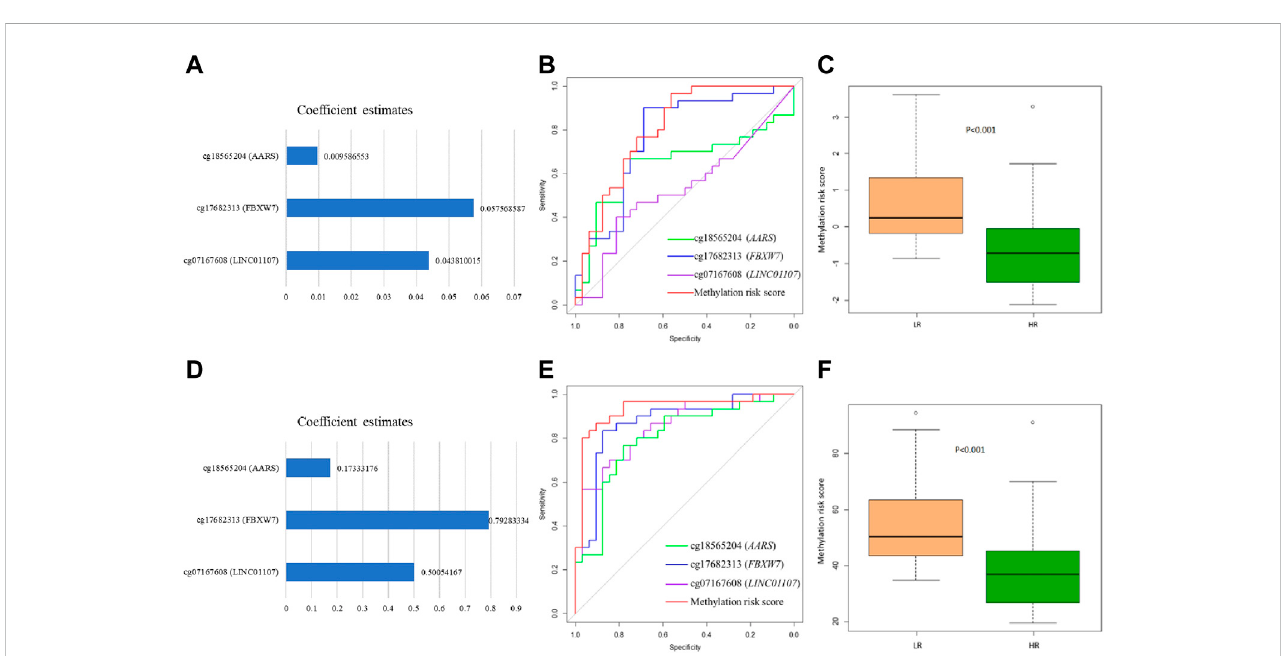
FIGURE 2 Receiver operating characteristic (ROC) curves and forest plot of methylation probes and methylation risk score using logistic regression and support vector machine in LR (low resilience) versus HR (high resilience) groups in the validation set. (A) Forest plot showing methylation probe coef fi cient estimates for methylation risk scores by logistic regression. (B) ROC curves showing the capabilities of logistic regression to discriminant LR. (C) Box plot showing methylation risk scores of the three methylation probes in LR and HR by logistic regression. (D) Forest plot showing methylation probe coef fi cient estimates for methylation risk scores by support vector machine. (E) ROC curves showing the capabilities of support vector machine to discriminant LR. (F) Box plot showing methylation risk scores of the three methylation probes in LR and HR by support vector